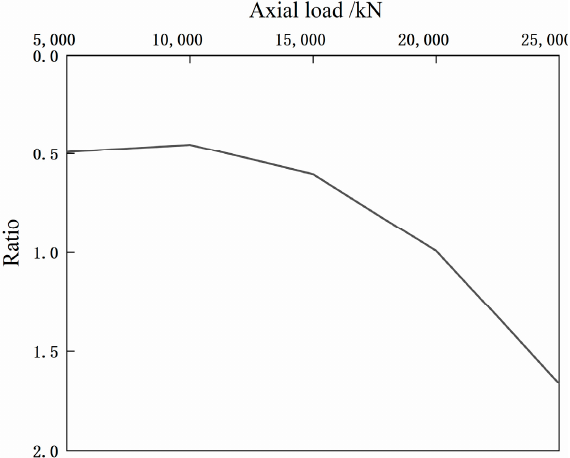
Figure 16. The ratio curve of end resistance to average friction resistance.